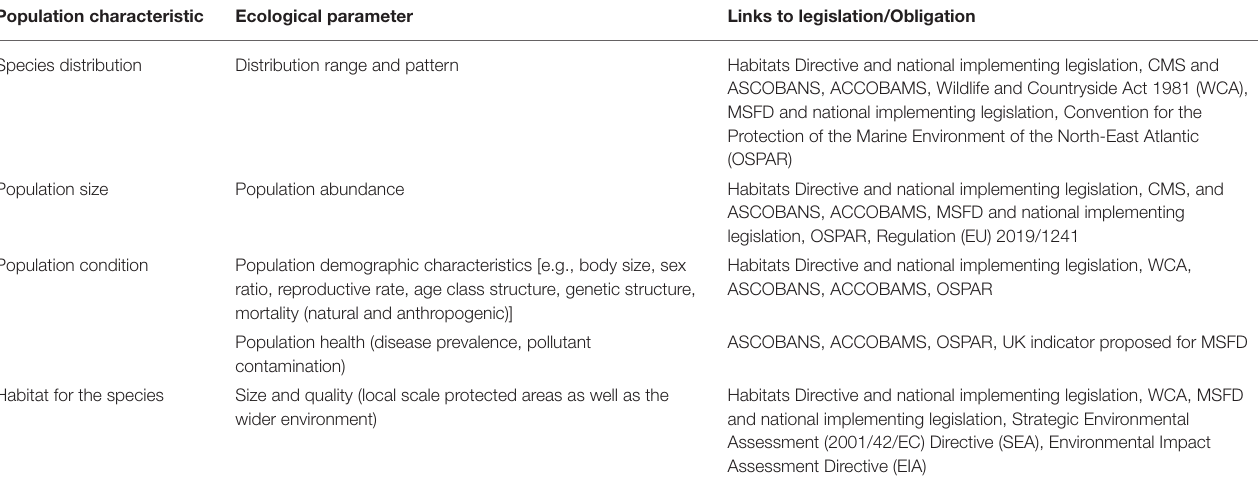
TABLE 2 | Summary of conservation and monitoring commitments in the EU and United Kingdom [after IAMMWG et al. (2015)]. Population characteristic Ecological